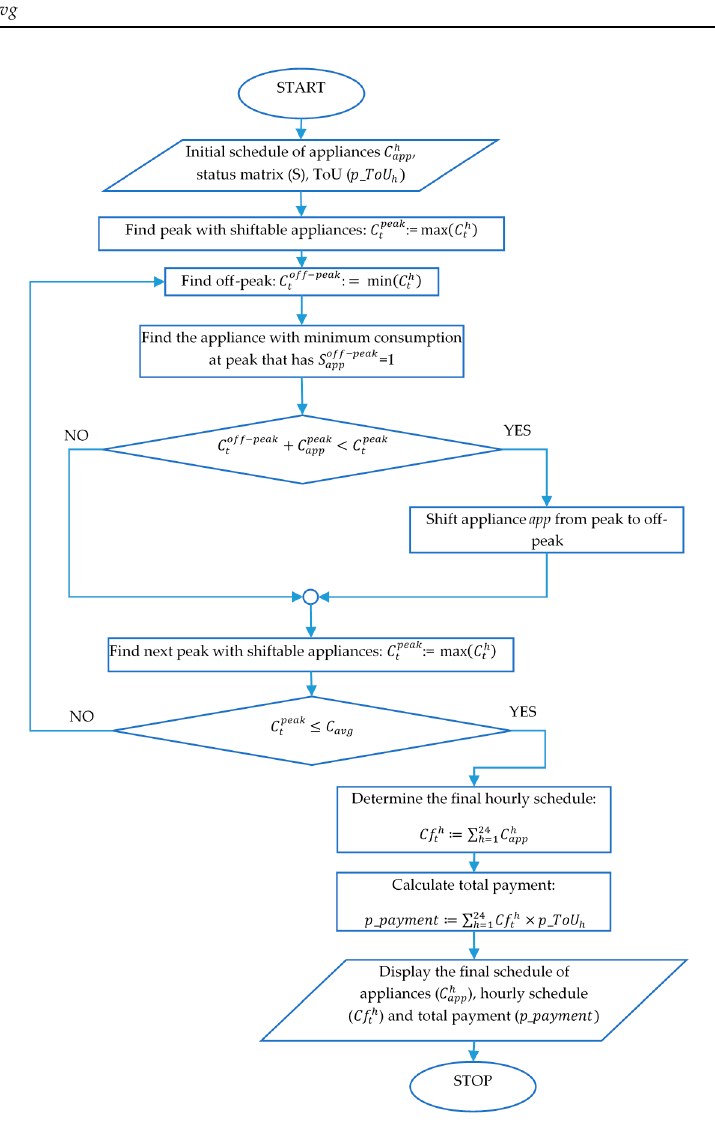
Figure 5. Flowchart of the shifting Algorithm 1.